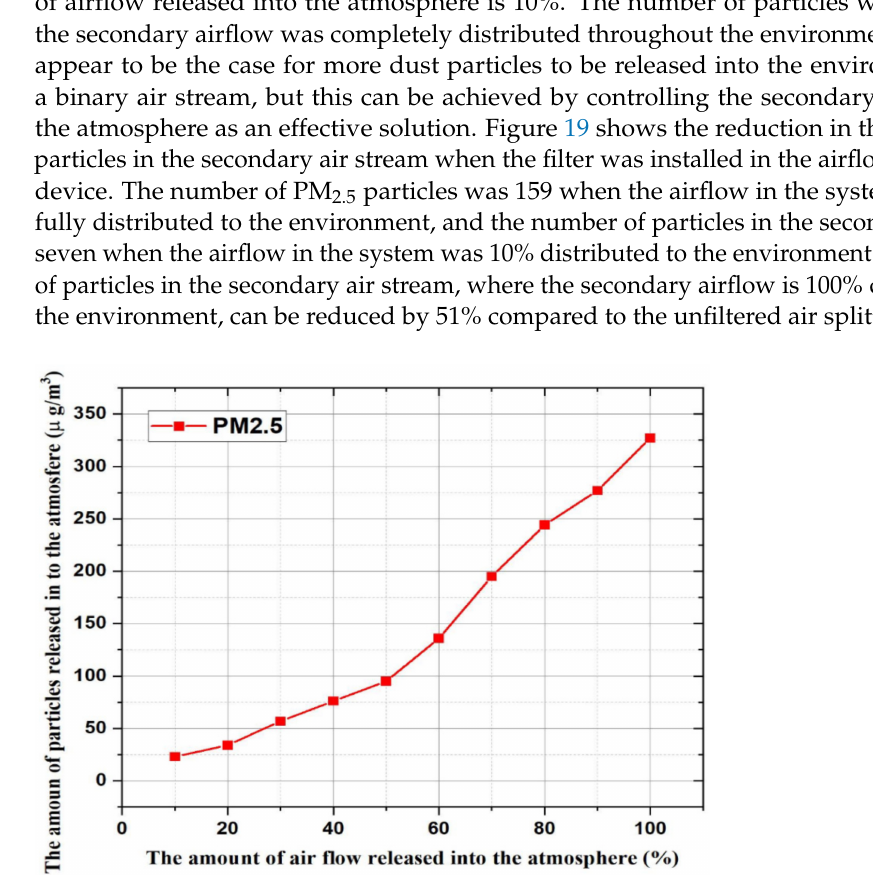
Figure 18. The secondary airflow channel that distributes the airflow separation device to the environment is